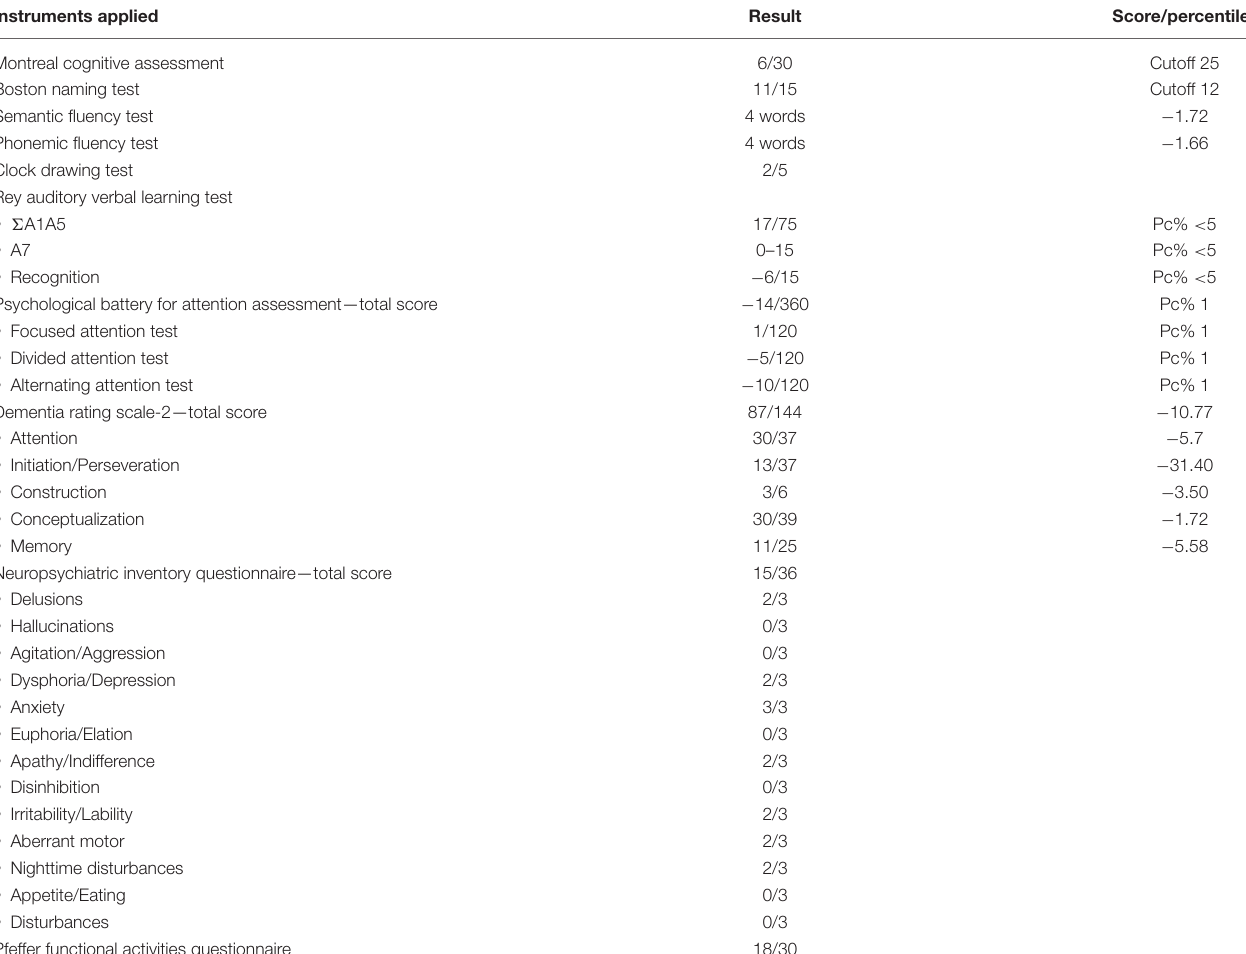
TABLE 1 | Results of the neuropsychological